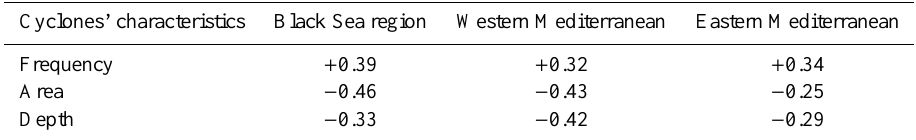
Table 2. Mean correlation coe ffi cients between the SOI and January–March characteristics of cyclones (lag 5–7 months). All coe ffi cients are significant on 90% confidence